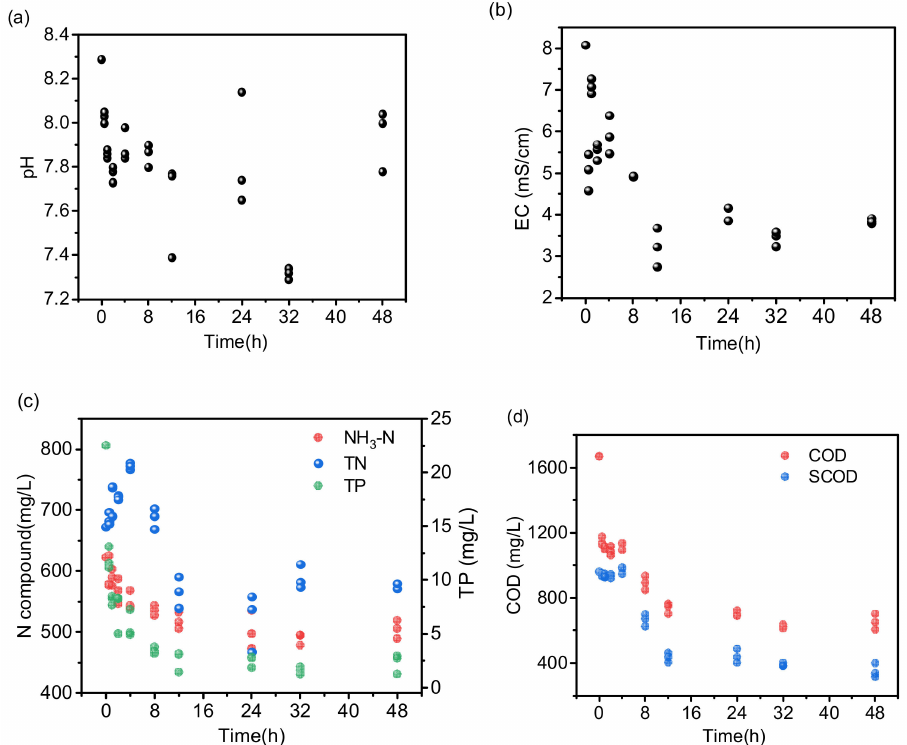
Figure 3. Variation of ( a ) pH, ( b ) EC, ( c ) nutrients, ( d ) organics in the soil adsorption kinetics